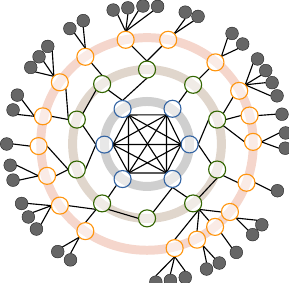
Figure 2: Example of a topology created using Asymmet- ricHierarchicalTopologyHelper . Routers are represented as empty circles; hosts are represented as filled circles.